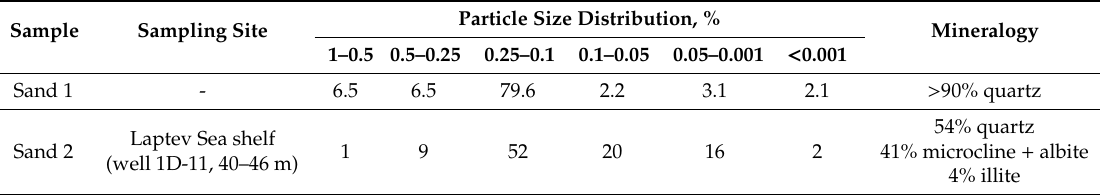
Table 1. Particle size distribution and mineral composition of investigated sediments.